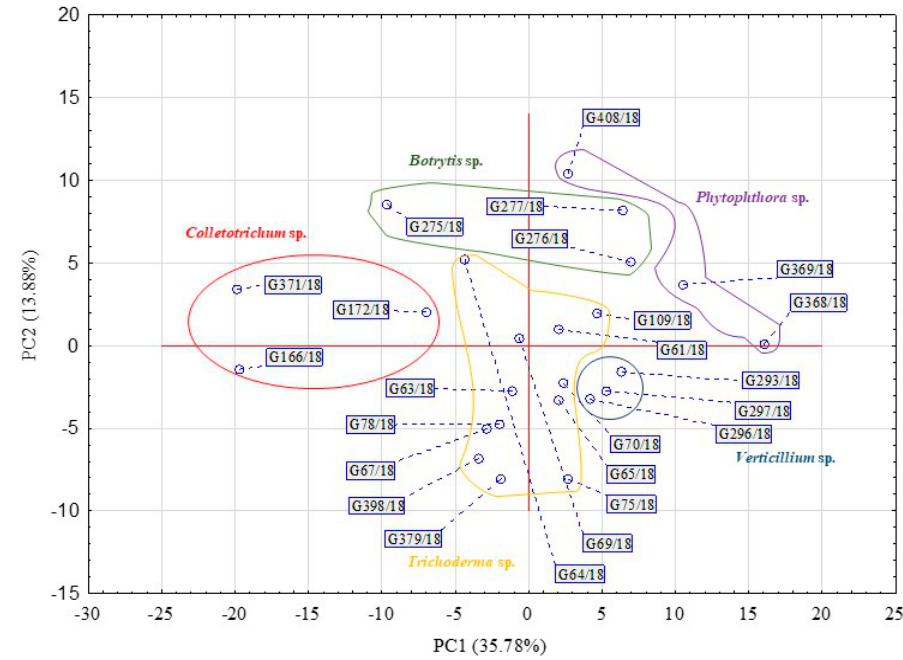
Figure 2. Principal component analysis (PCA) calculated on the basis of the pathogenic fungi and beneficial Trichoderma isolates’ response to FF Biolog ® substrates at 192 h ( n = 3). Table 1. Rotated factor loadings with the principal components (PC) distinguished (PC1: 35.78% and PC2 13.88%), calculated on the basis of the pathogenic fungi and beneficial Trichoderma isolates